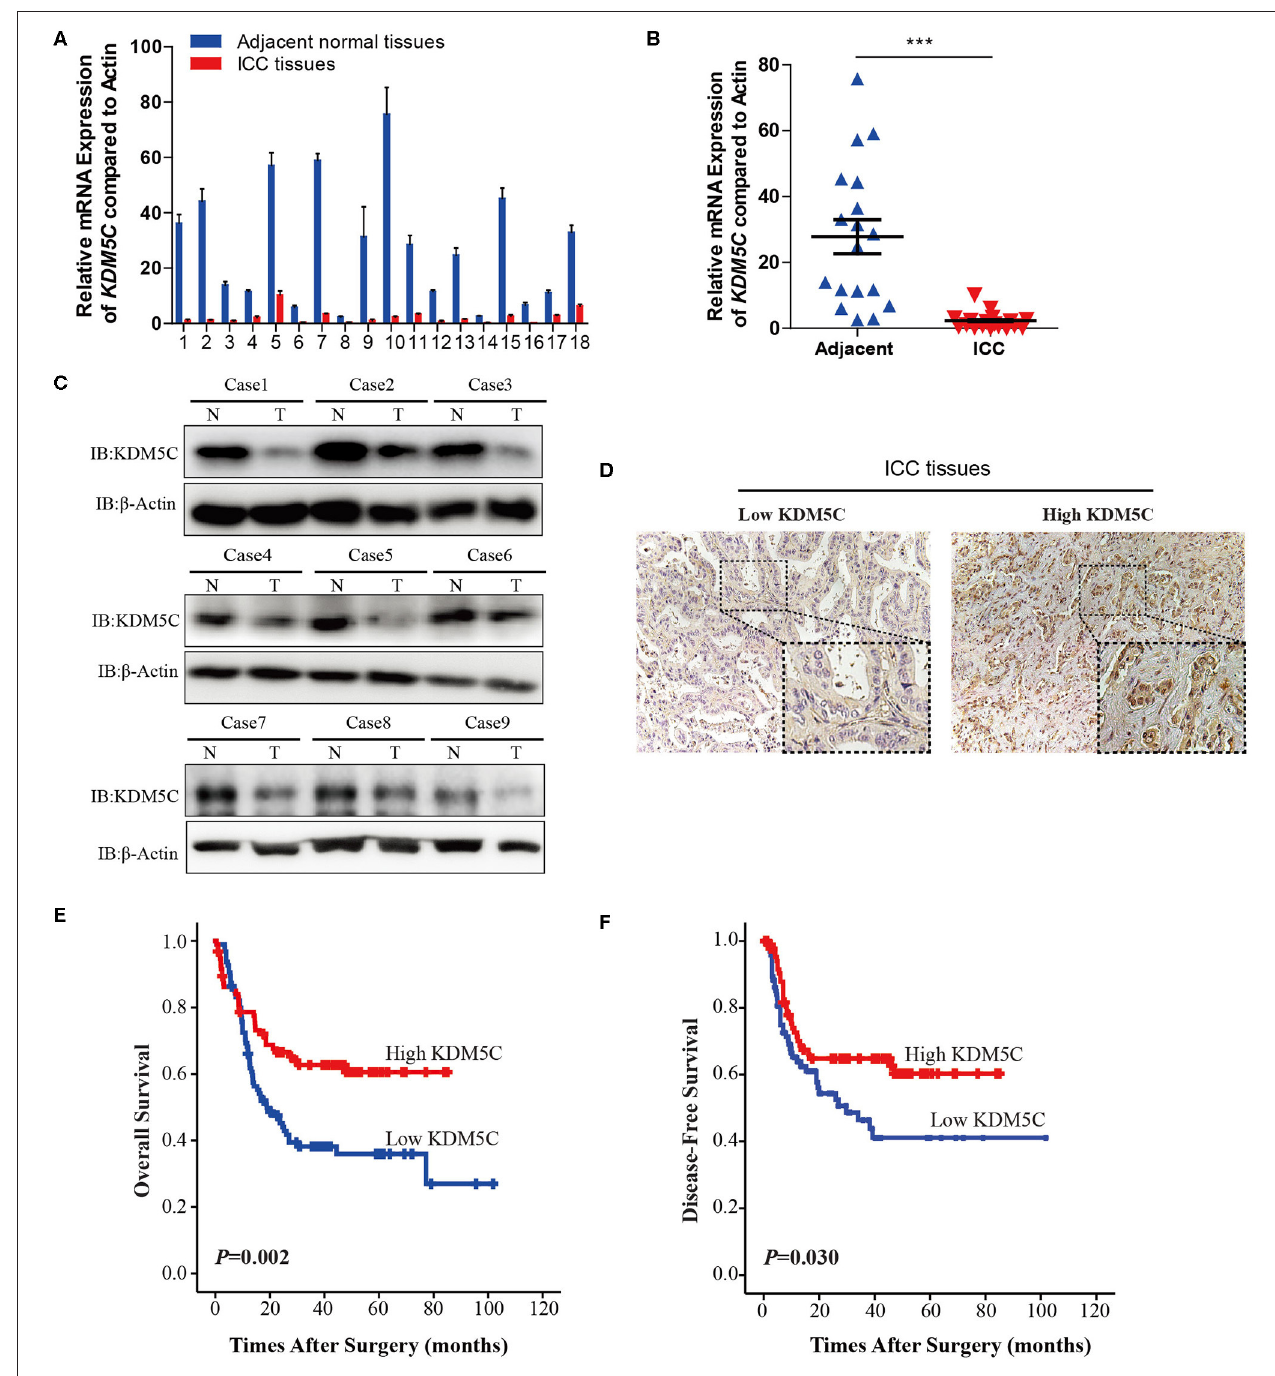
FIGURE 1 | Reduction of KDM5C expression is correlated with poor prognosis in ICC. (A) qRT-PCR assay of KDM5C mRNA expression in 18 paired groups of specimens of human ICC and non-tumor adjacent tissues. (B) Comparison of the expression of KDM5C mRNA in human ICC and adjacent non-tumor liver tissues. The mRNA level of KDM5C was significantly downregulated in ICC tissues. (C) Western blot analyses of KDM5C in human ICC and adjacent non-tumor liver tissues. (D) Immunohistochemical patterns of KDM5C of human ICC specimens. Scale bars, 50 µ m (upper) and 20 µ m (lower). (E,F) Kaplan-Meier survival analysis of the overall survival (E) and disease-free survival (F) of ICC patients which were divided into two different groups according to the protein levels of KDM5C, which were determined by immunohistochemical assay. Data are presented as the mean ± SD. *** p < 0.001. All results are from three independent experiment.